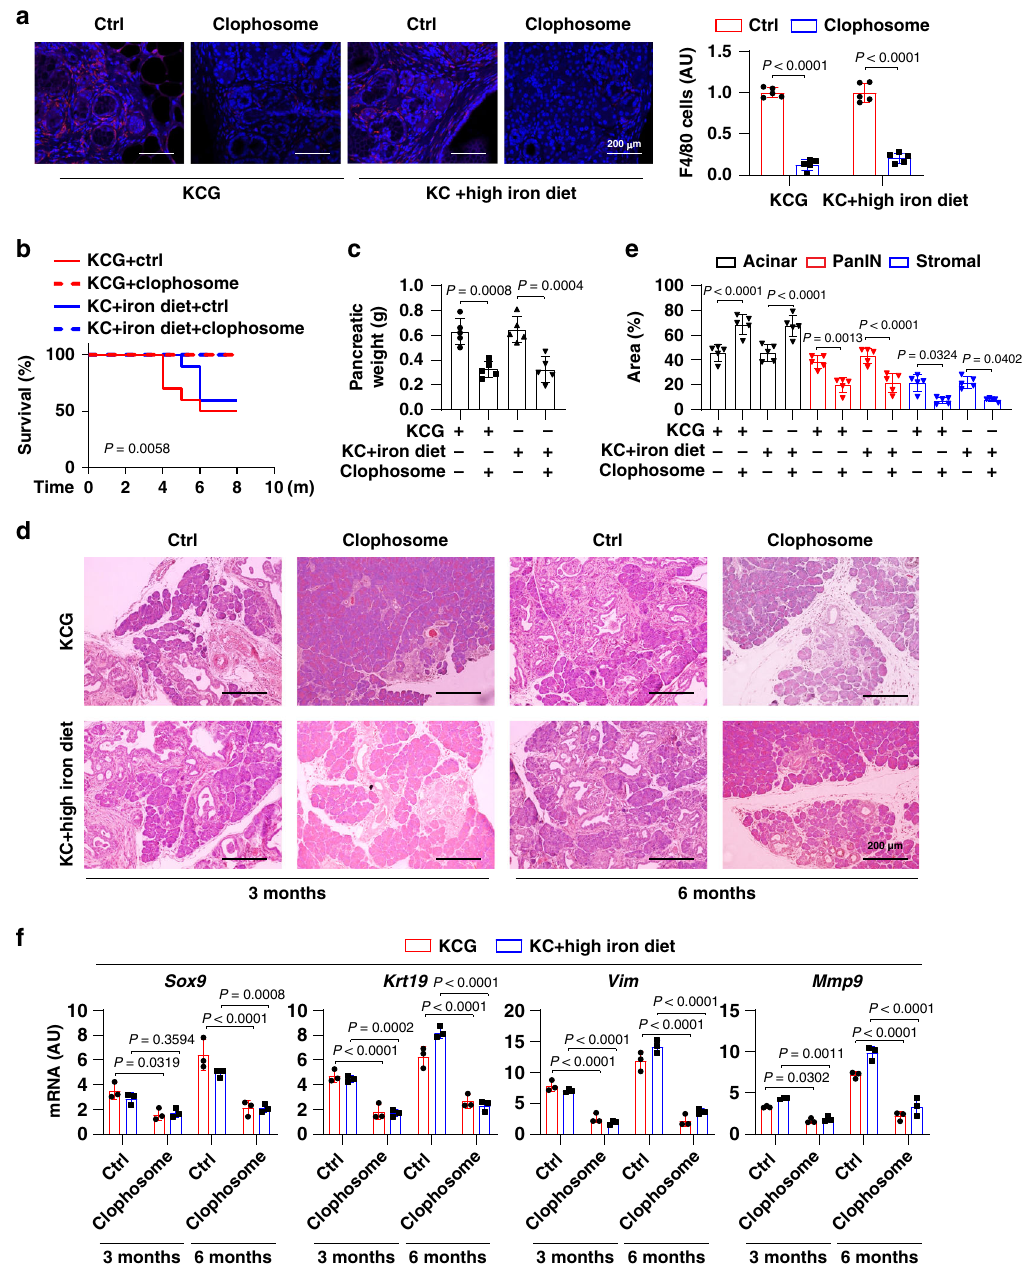
Fig. 3 Macrophage depletion decreases pancreatic tumorigenesis. a Representative images of immuno fl uorescence staining of macrophages (red) in the pancreas in indicated mice at the age of 3 months after treatment with clophosome or control liposomes (Ctrl) ( n = 5 mice/group; one-tailed t test). b Survival of Pdx1-Cre;K-Ras G12D/ + ;Gpx4 − / − (KCG) or Pdx1-Cre;K-Ras G12D/ + (KC) mice with high-iron diets after treatment with clophosome or control liposomes (Ctrl) ( n = 10 mice/group; one-sided log-rank [Mantel – Cox] test). c Pancreatic weight of the indicated mice (6 months; n = 5 mice/group; one way ANOVA with Tukey ’ s multiple comparisons test). d Representative pancreas histology of the indicated mice. e Percentages of histological structures in the pancreas of the indicated mice (6 months; n = 5 mice/group; two-way ANOVA with Tukey ’ s multiple comparisons test). f Relative gene expression in the pancreas of the indicated mice ( n = 3 mice/group; two-way ANOVA with Tukey ’ s multiple comparisons test). Data in a , c , e , and f are presented as mean ± SD. Data are from two or three independent